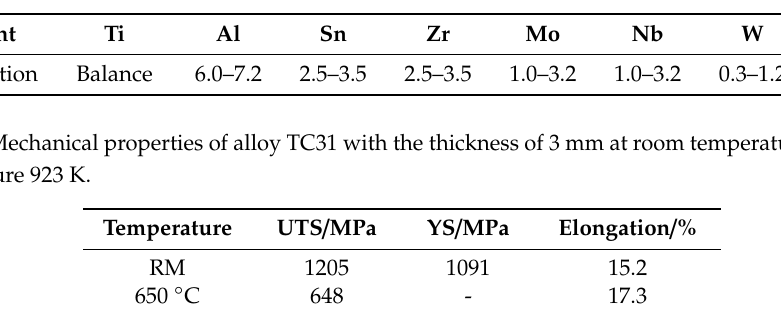
Table 1. The composition of high-temperature titanium alloy TC31 (wt%).